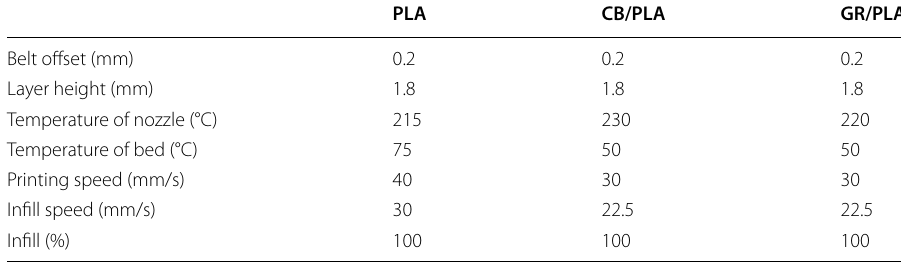
Table 2 CFDM 3D printing conditions with various